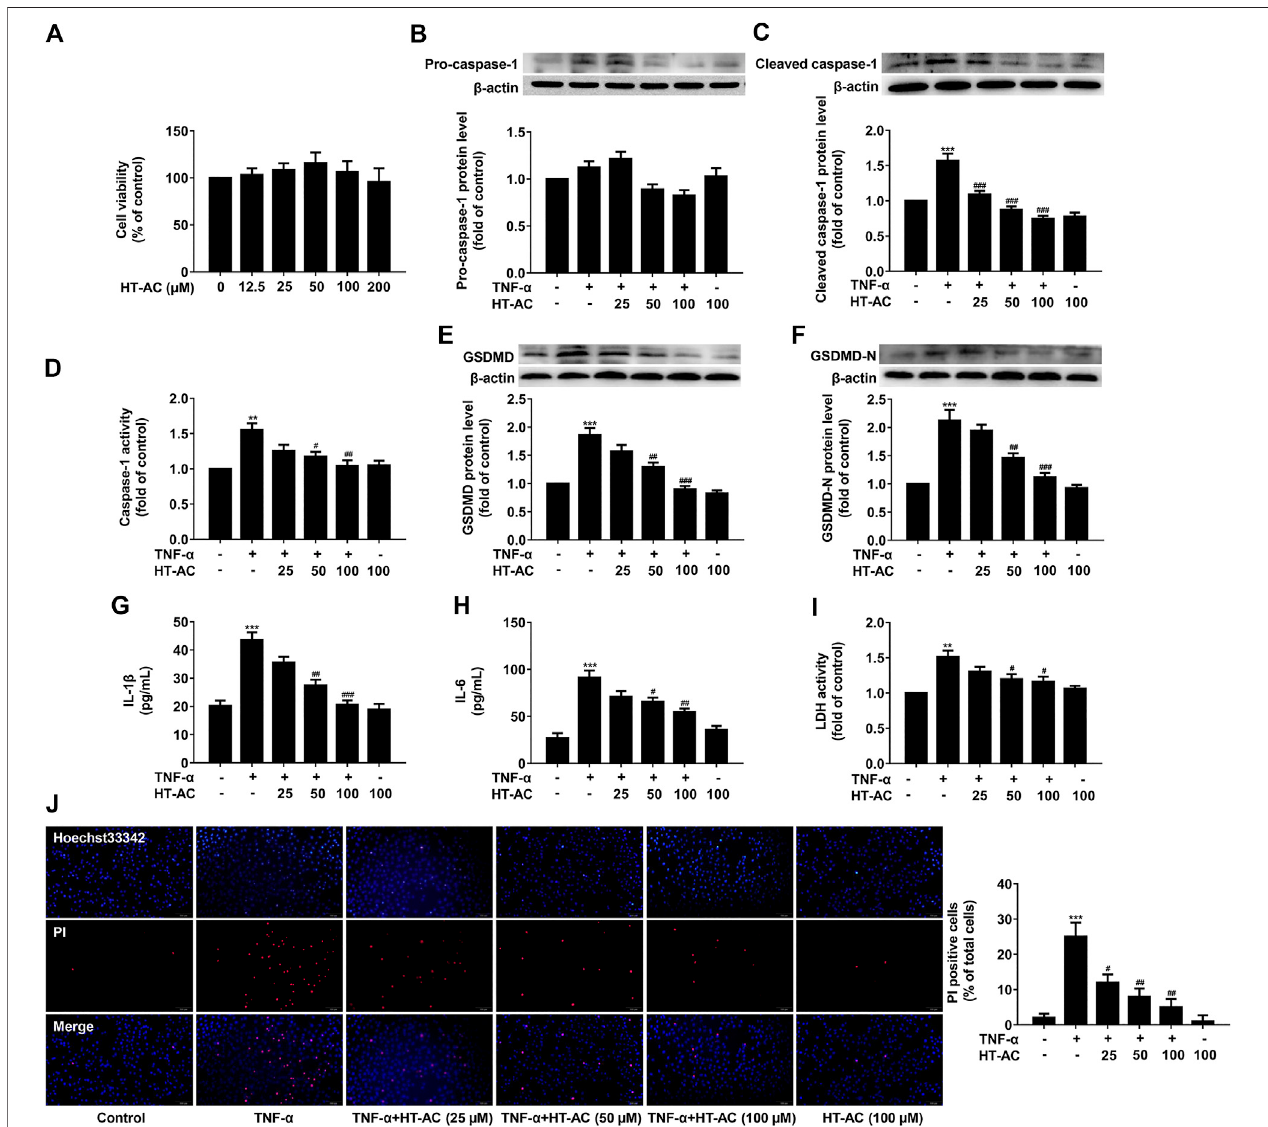
FIGURE3| HT-ACinhibitedpyroptosisinTNF-stimulatedHUVECs (A) ThecellviabilitywasmeasuredafterincubationwithvariousconcentrationsofHT-AC(12.5, 25,50,100and200 μ mol/L)for13 husingtheCCK8assay.TheHUVECsweretreatedwithdifferentconcentrationsofHT-AC(25,50and100 μ mol/L)for1 h,andthen stimulated with TNF- α (40 ng/ml) for 12 h (B,C) The protein expressions of pro-caspase-1 and cleaved caspase-1 were determined by Western blotting (D) Caspase-1 activity was assayed using the caspase-1 activity assay kit (E,F) The protein expressions of GSDMD and GSDMD-N were determined by Western blotting (G,H) The concentrations of IL-1 β and IL-6 in cellular supernatant of HUVECs were detected by ELISA assay (I) The LDH release was evaluated with a cytotoxicity detection LDHkit (J) Double- fl uorescentstainingwithPI(red)andHoechst33,342(blue)wasusedtoassesstheformationofmembraneporesduringpyroptosis, × 200.Scalebar indicates 100 μ m ** p < 0.01, *** p < 0.001 vs. control group; # p < 0.05, ## p < 0.01, ### p < 0.001 vs. TNF- α group. Results are expressed as mean ± SEM ( n (cid:2)